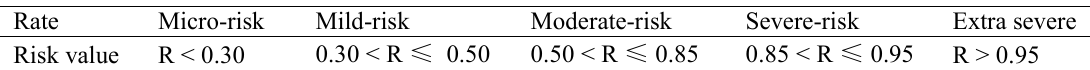
Fig. 1 Structure of the index system of groundwater exploitation risk evaluation in the main irrigation areas in Zhangye basin. Table 1 The risk rating of groundwater